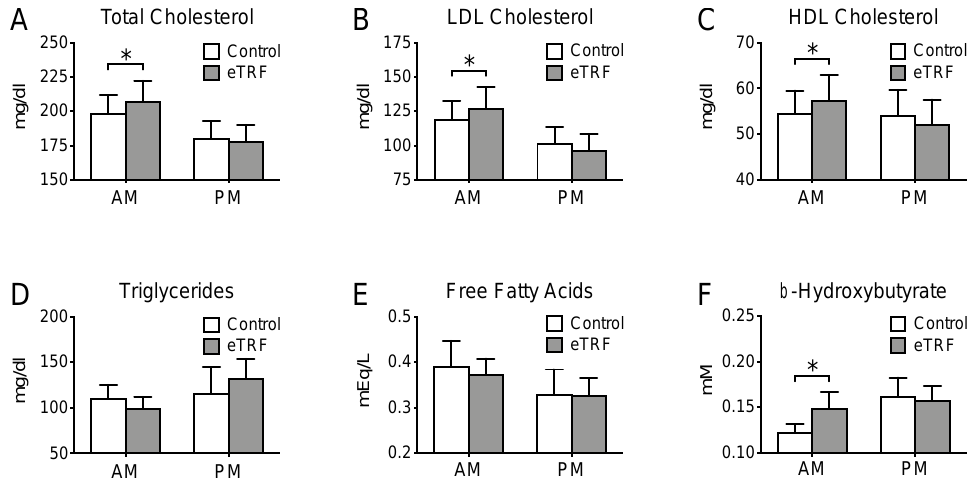
Figure 4. Lipids. Relative to the control arm, early time-restricted feeding (eTRF) increased fasting levels of ( A ) total cholesterol, ( B ) LDL cholesterol, ( C ) HDL cholesterol, and ( F ) β-hydroxybutyrate (ketones) in the morning (AM) but did not affect levels of ( D ) triglycerides or ( E ) free fatty acids. (A–F). Levels of all lipids were unaffected in the evening (PM). * p < 0.05 .